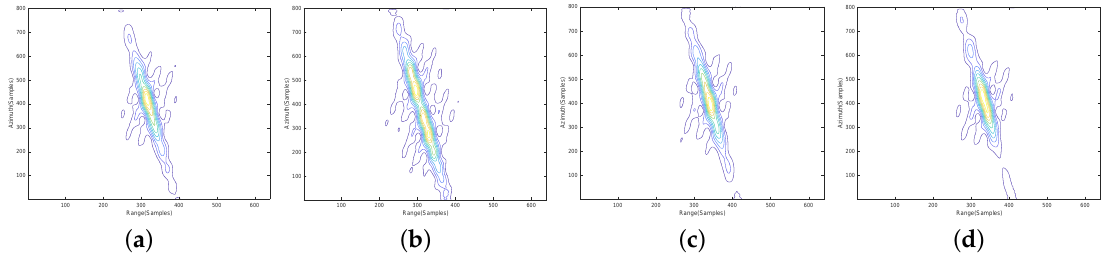
Figure 8. Imaging results of the NLCS-based 2-D SVD algorithm with inaccurate movement information. ( a ) P 1 . ( b ) P 2 . ( c ) P 3 . ( d ) P 4 .